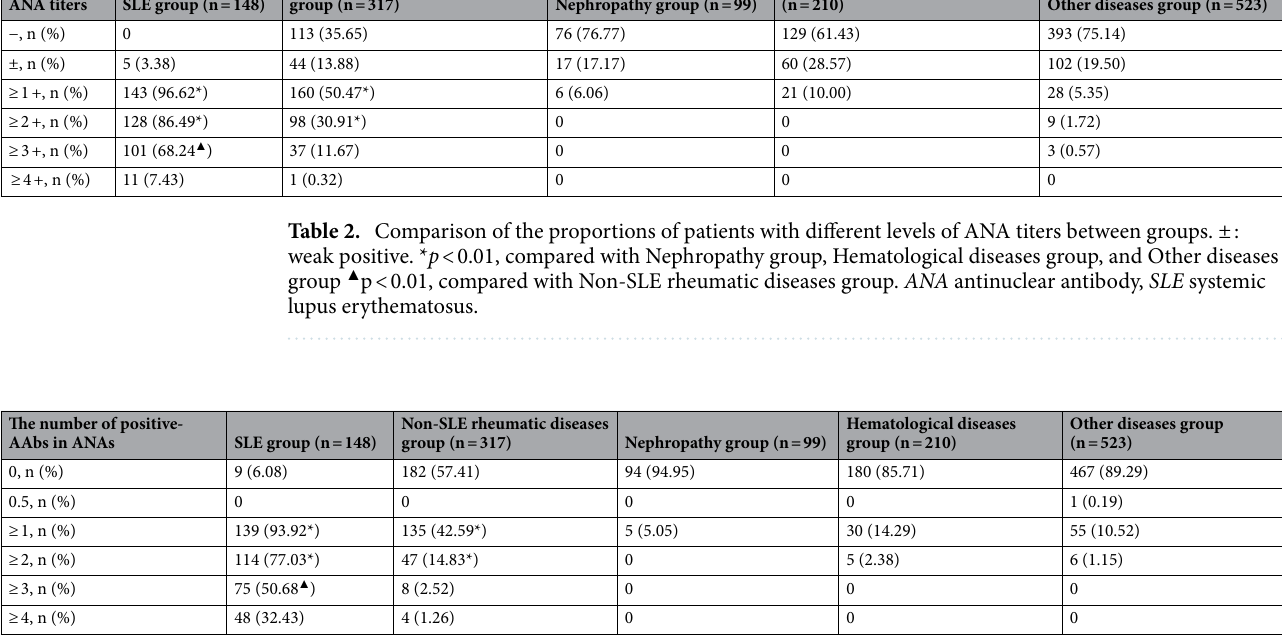
Table 3. Comparison of the proportions of patients with different numbers of AAbs between groups. 0.5: weak positive. * p < 0.01, compared with Nephropathy group, Hematological diseases group, and Other diseases group ▲ p < 0.01, compared with Non-SLE rheumatic diseases group. AAbs auto-antibodies, ANAs antinuclear antibodies, SLE systemic lupus